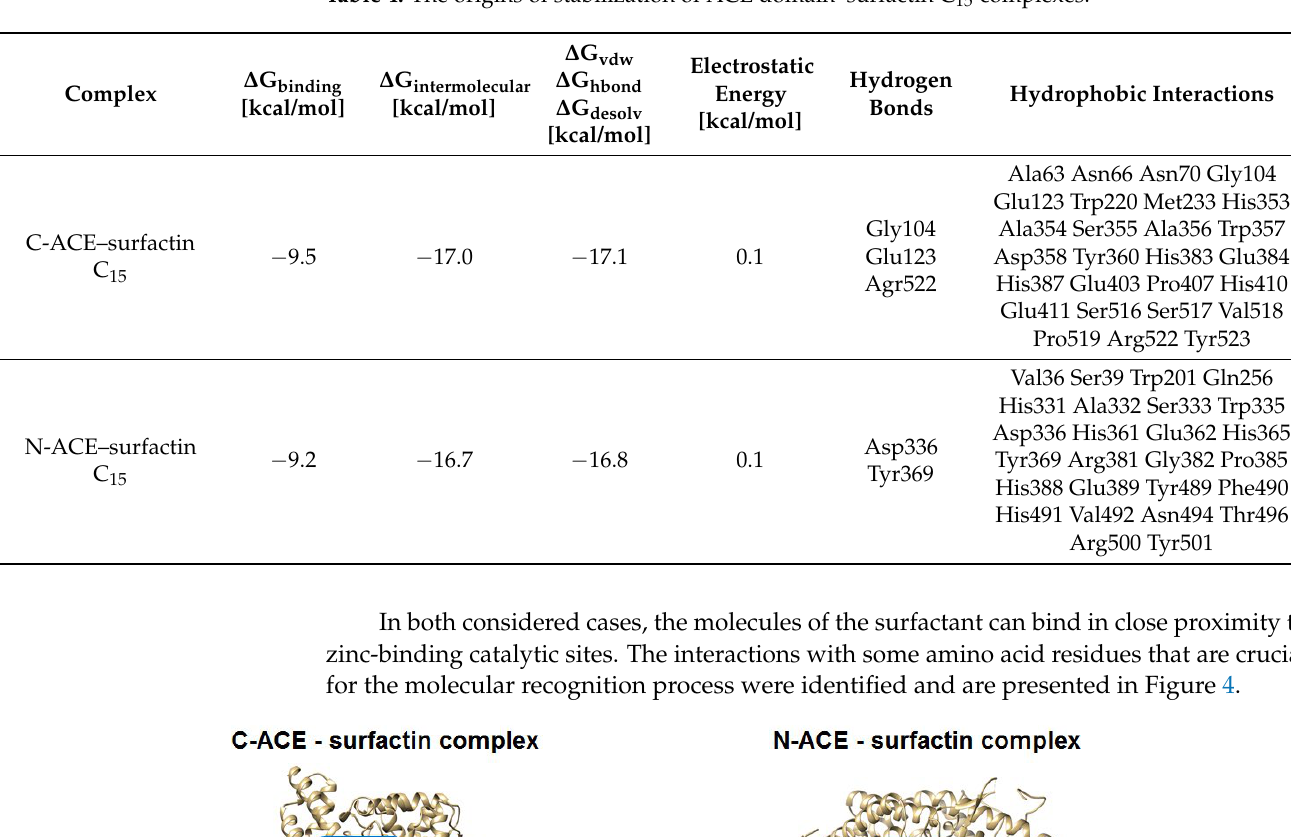
Table 4. The origins of stabilization of ACE domain–surfactin C 15 complexes.